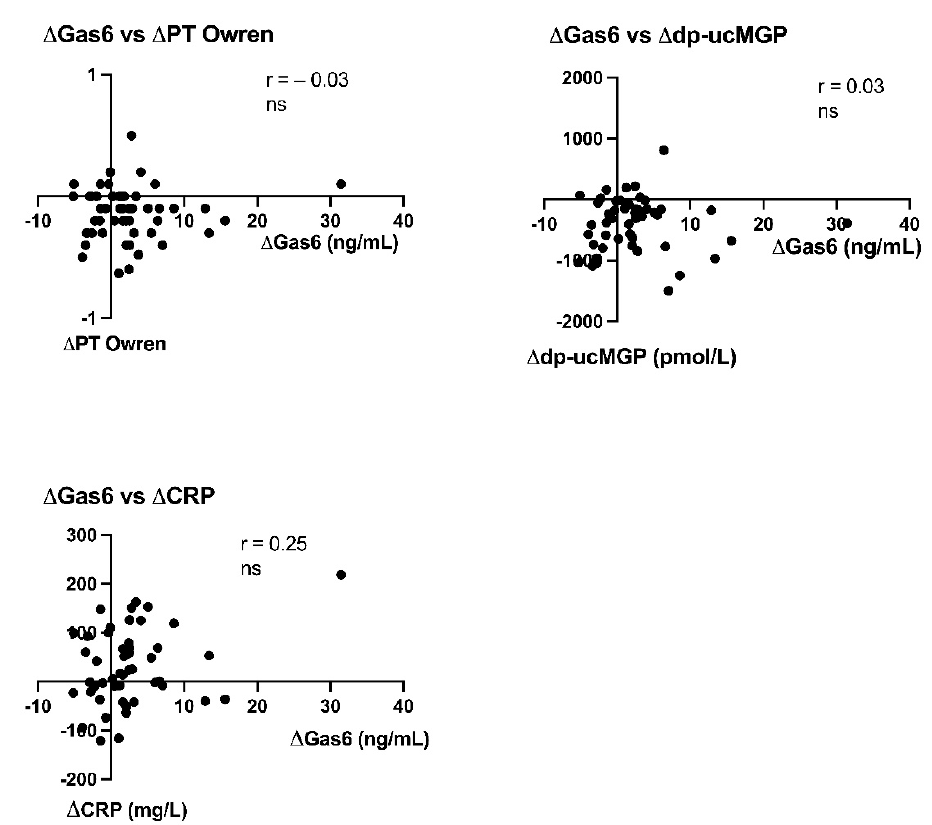
Figure 4. Correlations between delta-changes in growth arrest-specific gene 6 protein between sam- pling occasion ( ∆ Gas6) and delta-changes in PT Owren INR ( ∆ PT Owren), desphospho-carboxylated MGP ( ∆ dp-ucMGP) and C-reactive protein ( ∆ CRP) for the 52 patients. ns (no significant change).